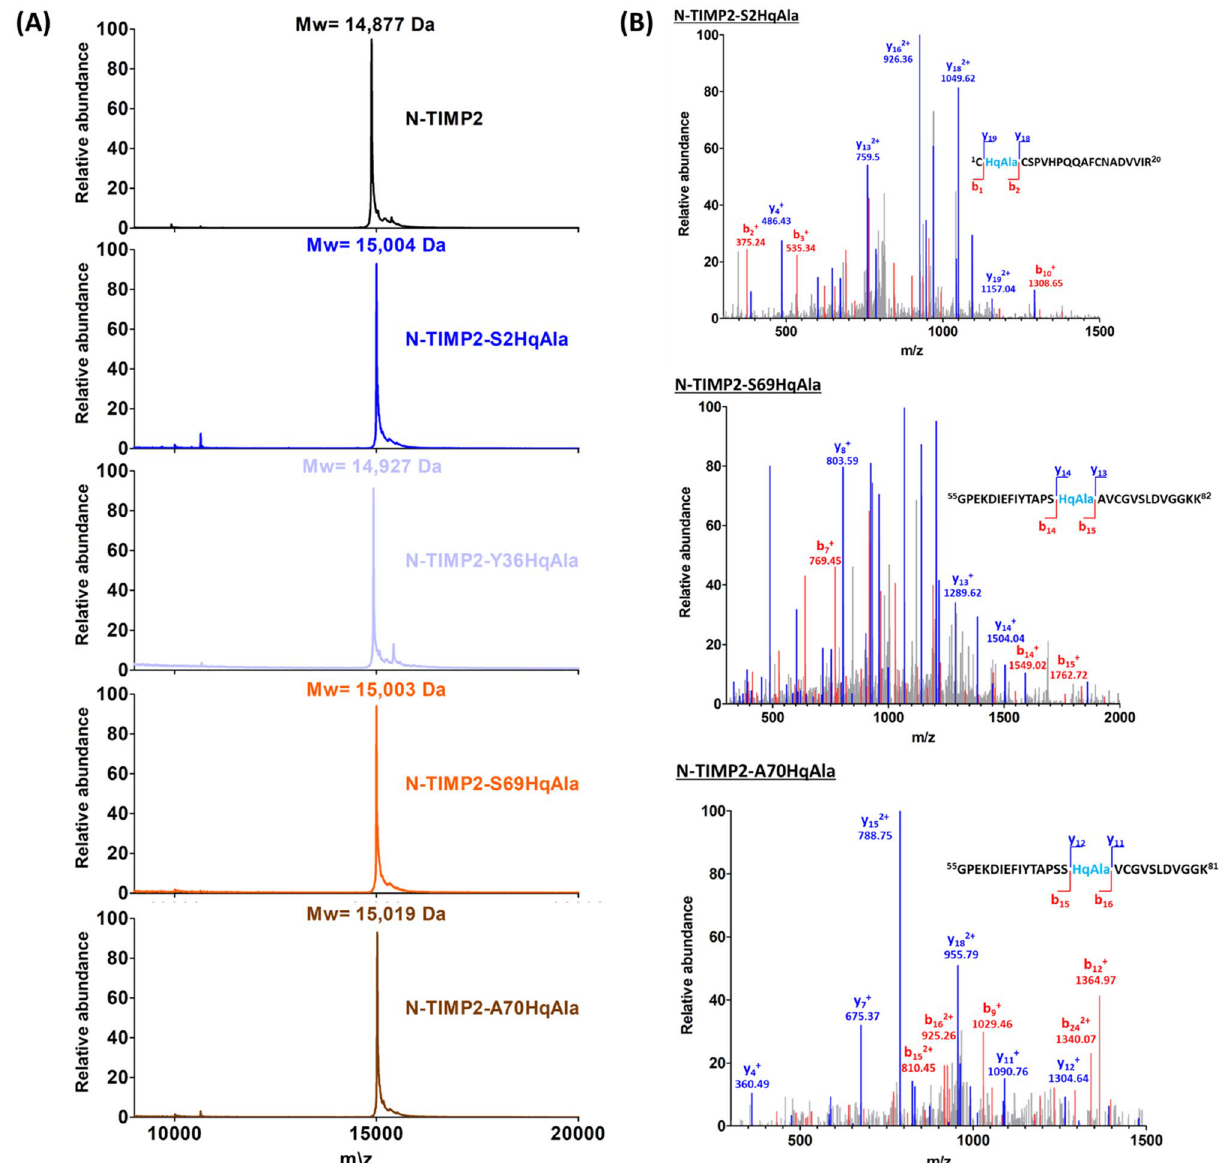
Figure 4. Mass spectrometry analysis of N-TIMP2-HqAla variants. ( A ) MALDI-TOF analysis of N-TIMP2- S2HqAla (expected mass: 15,010 Da), N-TIMP2-Y36HqAla (expected mass: 14,934 Da), N-TIMP2-S69HqAla (expected mass: 15,010 Da) and N-TIMP2-A70HqAla (expected mass: 15,026 Da), confirming the correct mass differences of ~ 127, ~ 51, ~ 127 and ~ 143 Da, respectively, between each variant and N-TIMP2 (upper row, expected mass: 14,883 Da). In all cases, the differences between expected (theoretical) and observed values were less than 0.1%. ( B ) LC–MS/MS analysis of N-TIMP2-S2HqAla, N-TIMP2-S69HqAla and N-TIMP2-A70HqAla confirming the incorporation of HqAla at the particular position in each